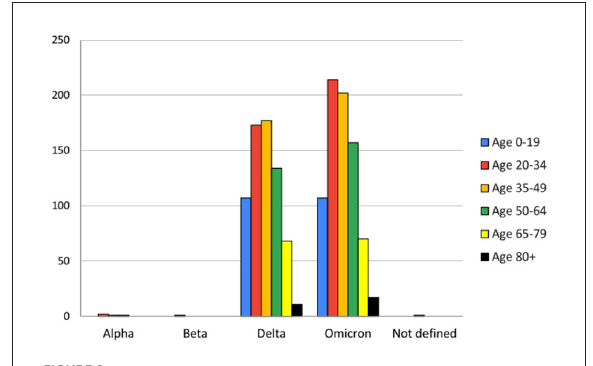
FIGURE2 Age-wise analysis of variants observed during the study period (from March 2021 to May